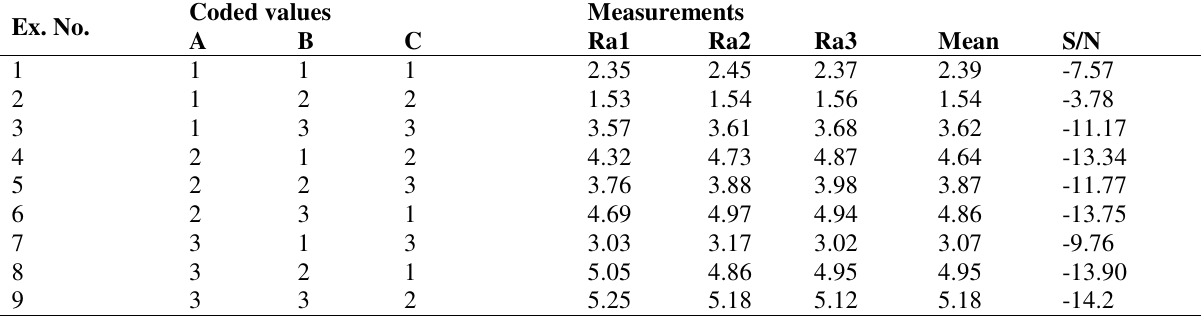
Results for bronze.